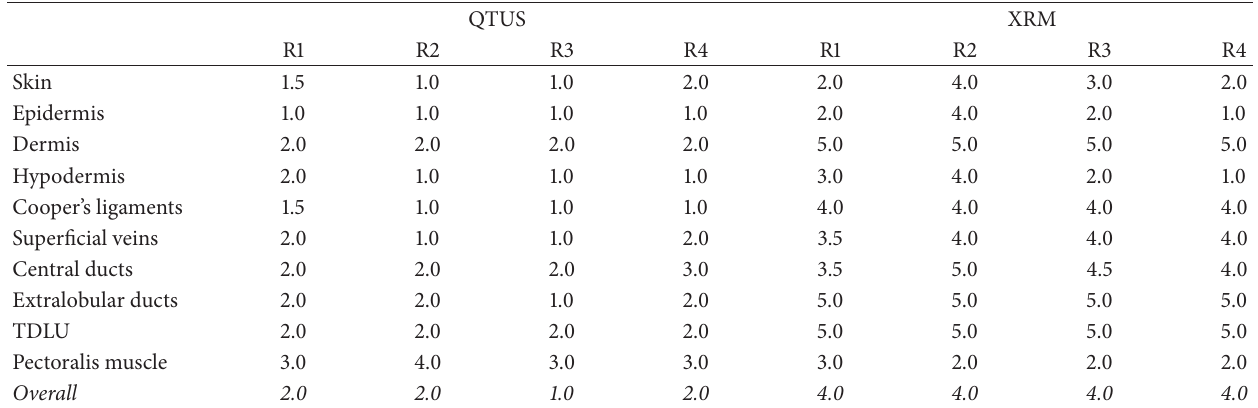
Figure 6: Higher magnification images of the cut surface of the cadaver breast (dissecting scope view) (left). The high magnification speed of sound image (upper right) of this same area and the results of biopsy of this same area showing glandular elements verified by histology (microscopic view). Solid bars represent 1 mm. Table 2: Median image quality scores by modality, reader, and